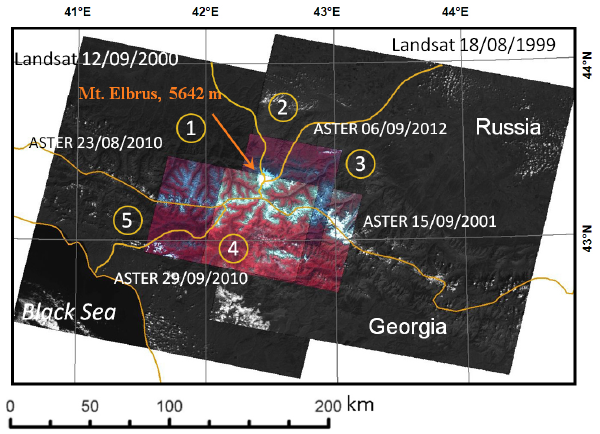
Figure 1. Study area and satellite imagery used for the analysis. The yellow lines show the Black Sea coastline, the MCR, and the catchment boundaries. The catchments are numbered as follows: (1) Kuban; (2) Malka; (3) Baksan; (4) Inguri; and (5)